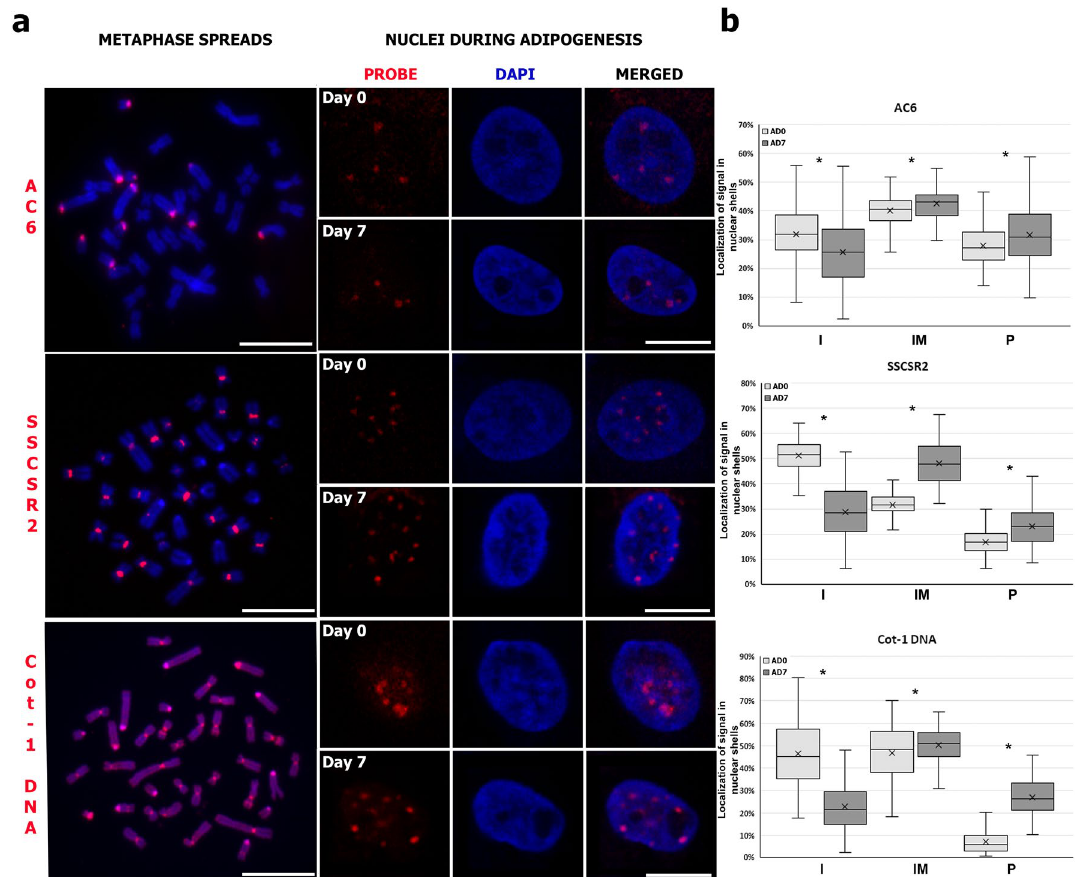
specific to the centromeres of acrocentric chromosomes (AC6), the centromeres of bi-armed chromosomes (SSCSR2), and Cot-1 DNA. Probes were labeled with Cy3 (red) and chromatin was counterstained with DAPI (blue). Scale bar: 10 µm. ( b ) The graphs show the spatial distribution of hybridization signals in 3D nuclear space. Statistically significant differences ( P < 0.05) are marked with asterisks. The number of nuclei analyzed was n = 256 for AC6, n = 256 for SSCSR2, and n = 251 for Cot-1